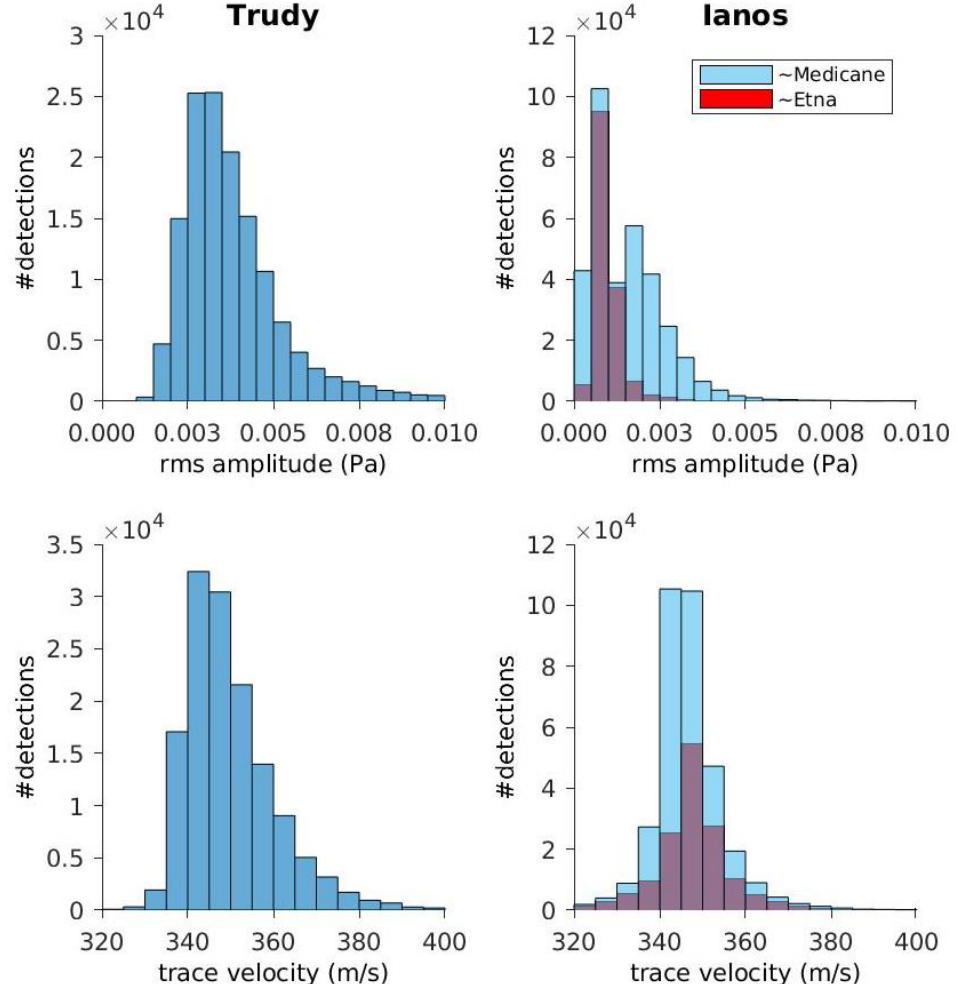
Figure 5. Distributions of rms amplitudes ( top ) and trace velocity ( bottom ) for detections related to Tudy ( left ) and to Ianos ( right ) in the higher frequency range 2–8 Hz. For Ianos, detections likely to be related to the Etna Volcano (see text for details) are plotted in red in transparency, on top of the detections thought to be only related to the medicane (in blue) (“#detections” means “number of infrasound